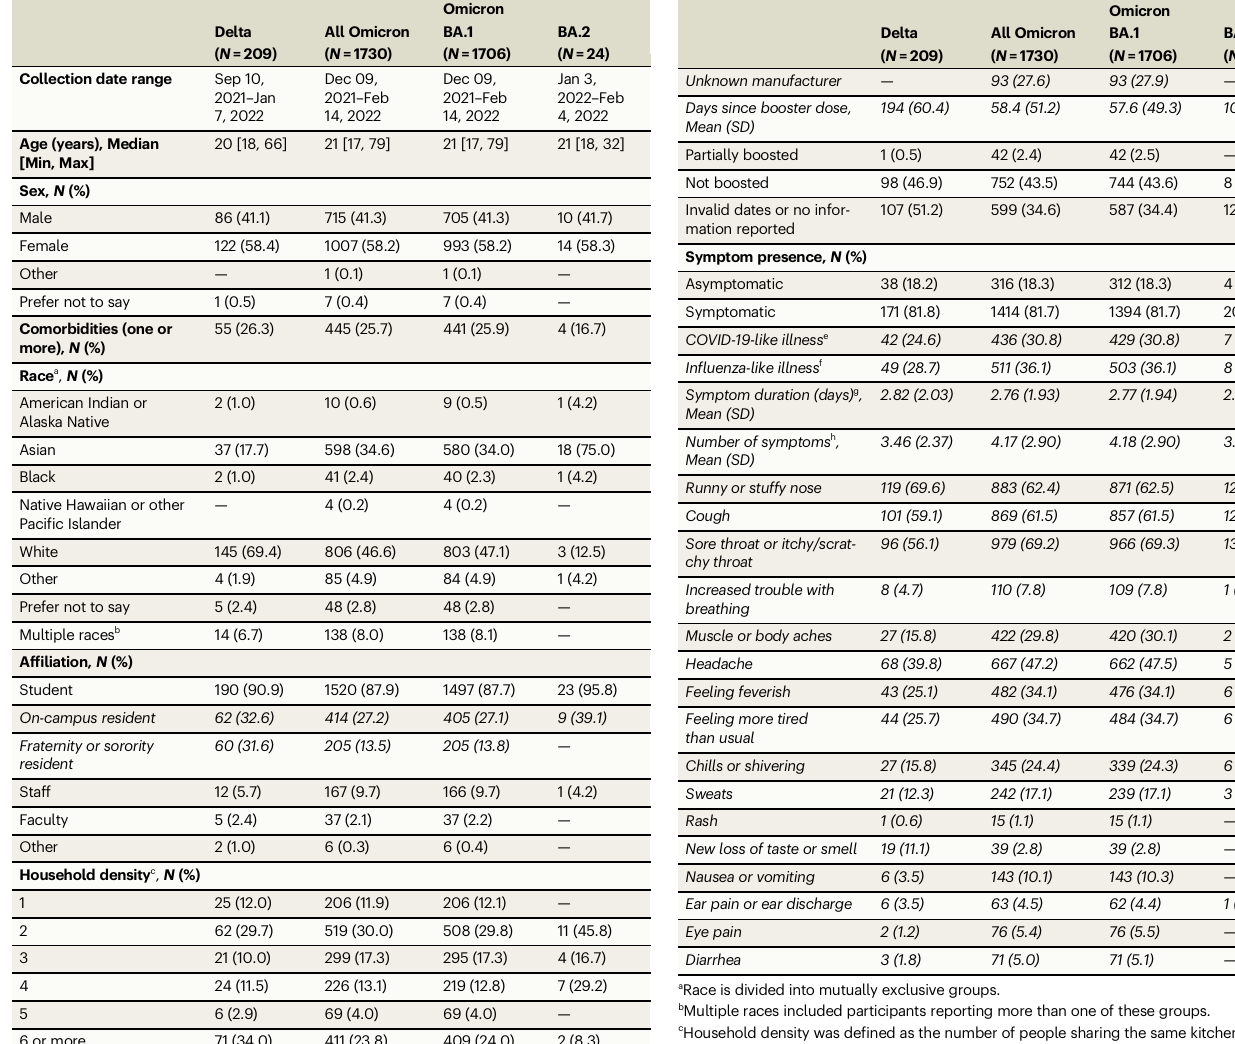
Table 1 | Demographic characteristics and symptom pro fi les for Delta and Omicron variant infected study participants, September 10, 2021, to February 14,